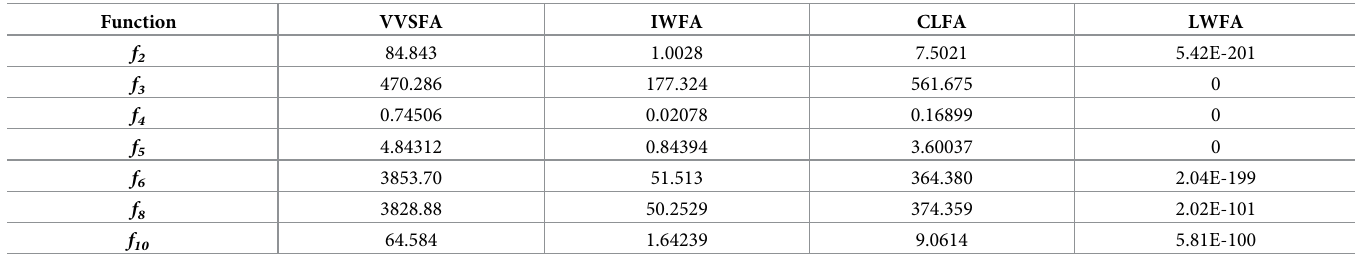
Table 3. Comparison results of LWFA and other improved FA with D = 100.